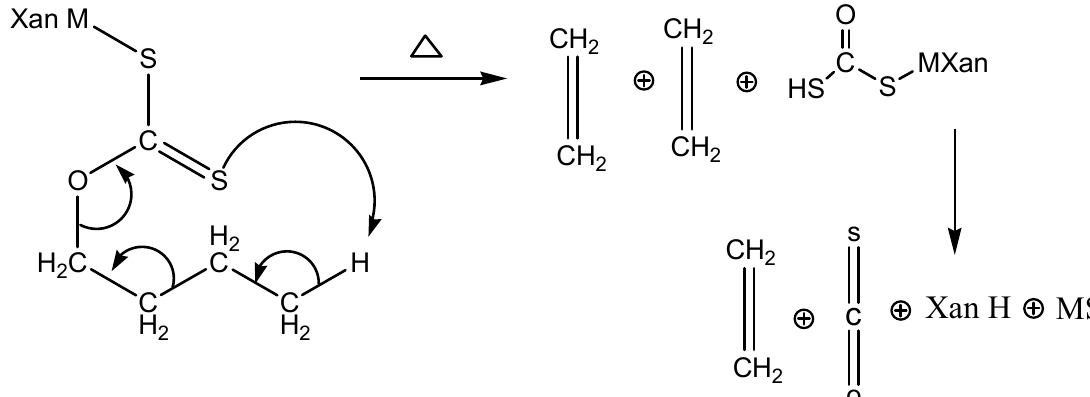
Figure 4. The suggested mechanism of the decomposition of the nickel xanthate complex into its derivatives through the Chugaev reaction.